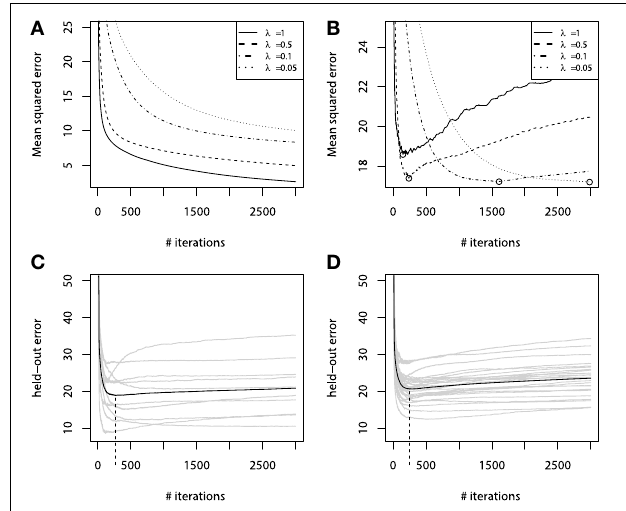
FIGURE 5 | Error curves for GBM fitting on sinc(x) data: (A) training set error; (B) validation set error. Error curves for learning simulations and number of base-learners M estimation: (C) error curves for cross-validation; (D) error curves for bootstrap